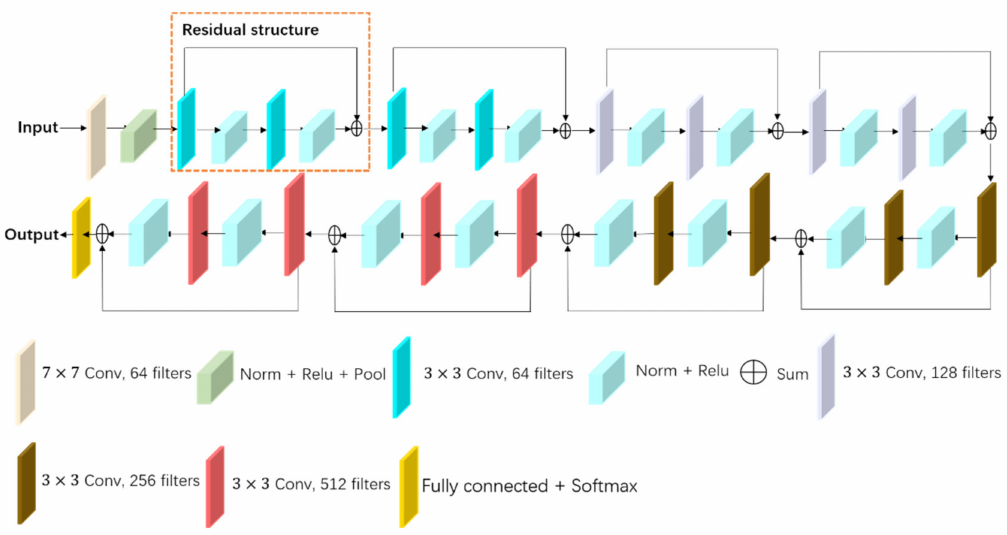
Figure 2. Structure depiction of ResNet-18 and was used in BO-DRNet’s encoder. ResNet-18 includes eight residual